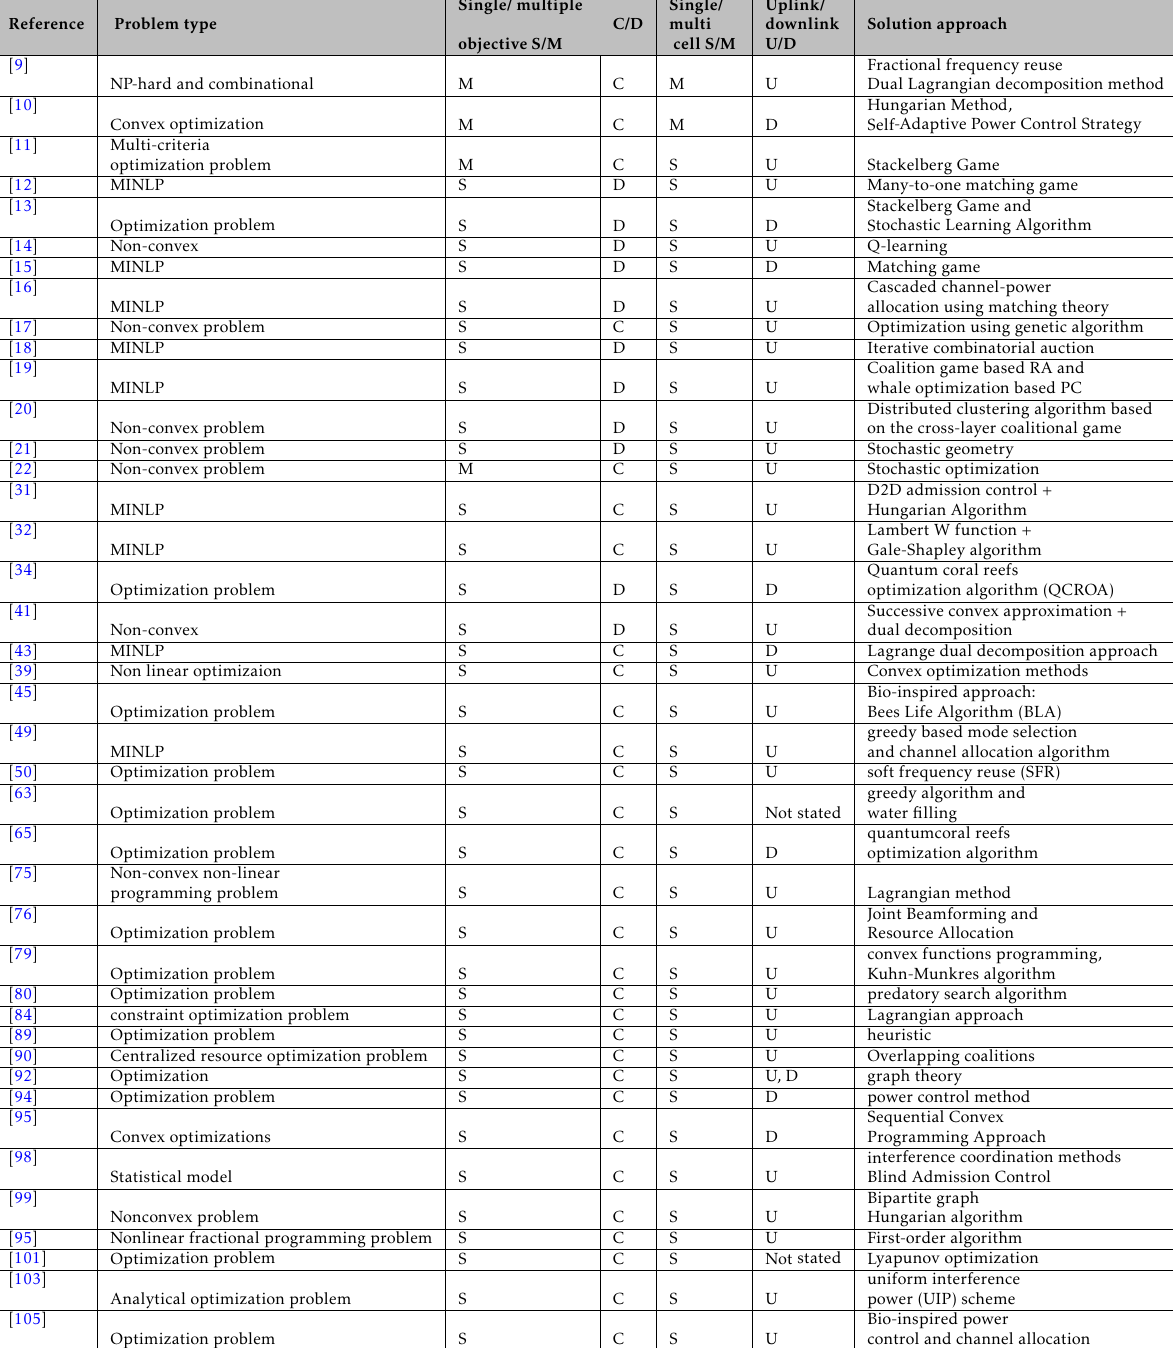
Table 11. Resource Allocation D2D communication: Comparison Based on Problem, Solution and System Characteristic Single/ multiple Single/ Uplink/ Reference Problem type C/D multi downlink Solution approach objective S/M cell S/M U/D